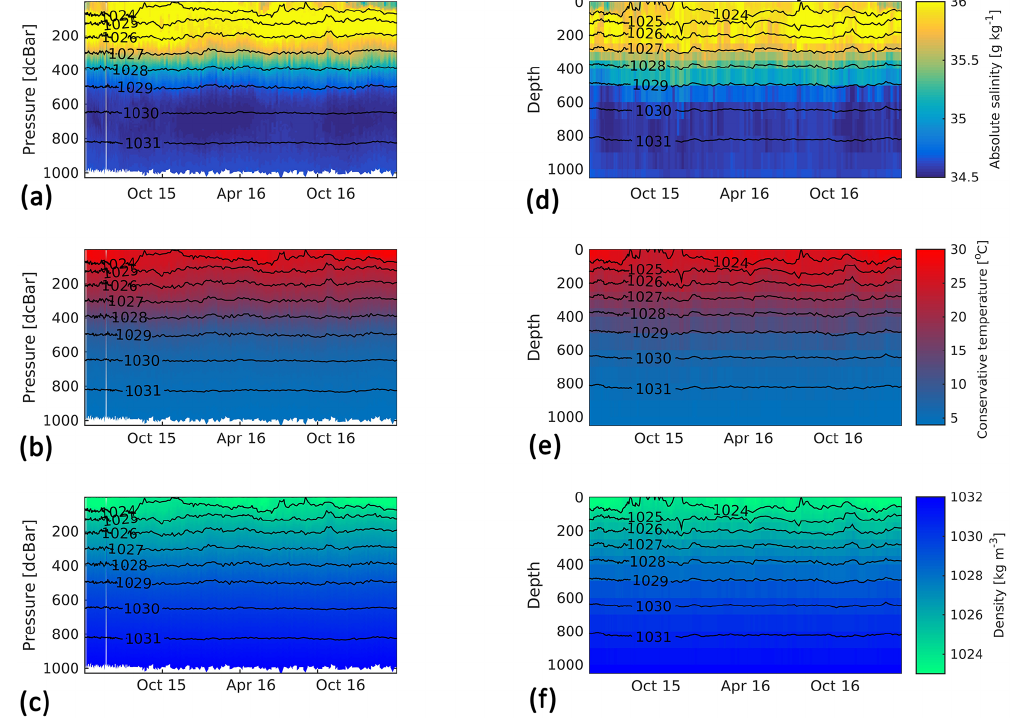
Figure C3. Profiles of (left side) float 687 and (right side) corresponding data from the HYCOM re-analysis over depth and time for (a, e) absolute salinity, (b, f) conservative temperature and (c, g) density. Every colored point corresponds to a measurement. The black lines indicate the isopycnals from 1024 to 1031kgm − 3